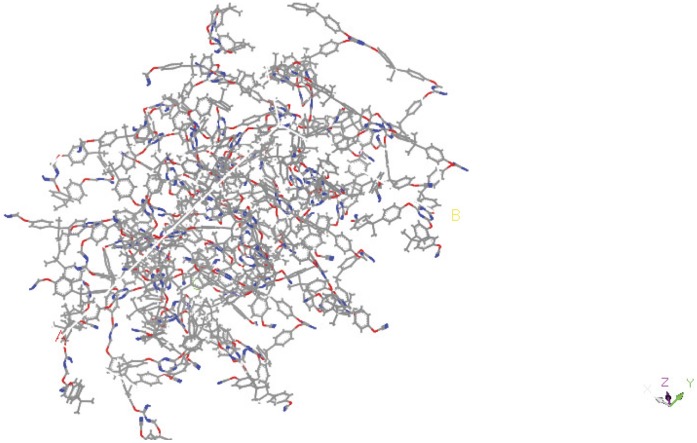
Image of [370
–130].